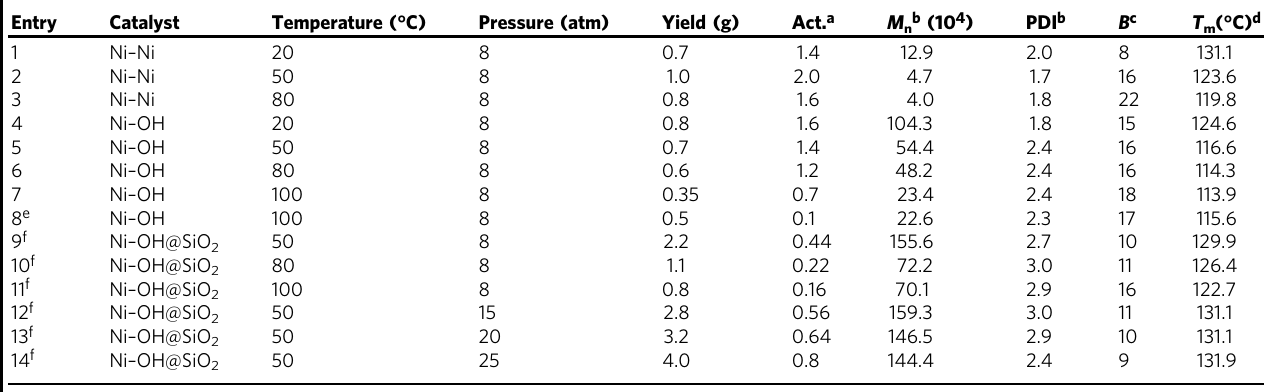
Table 3 Ethylene homopolymerization with Ni complexes.